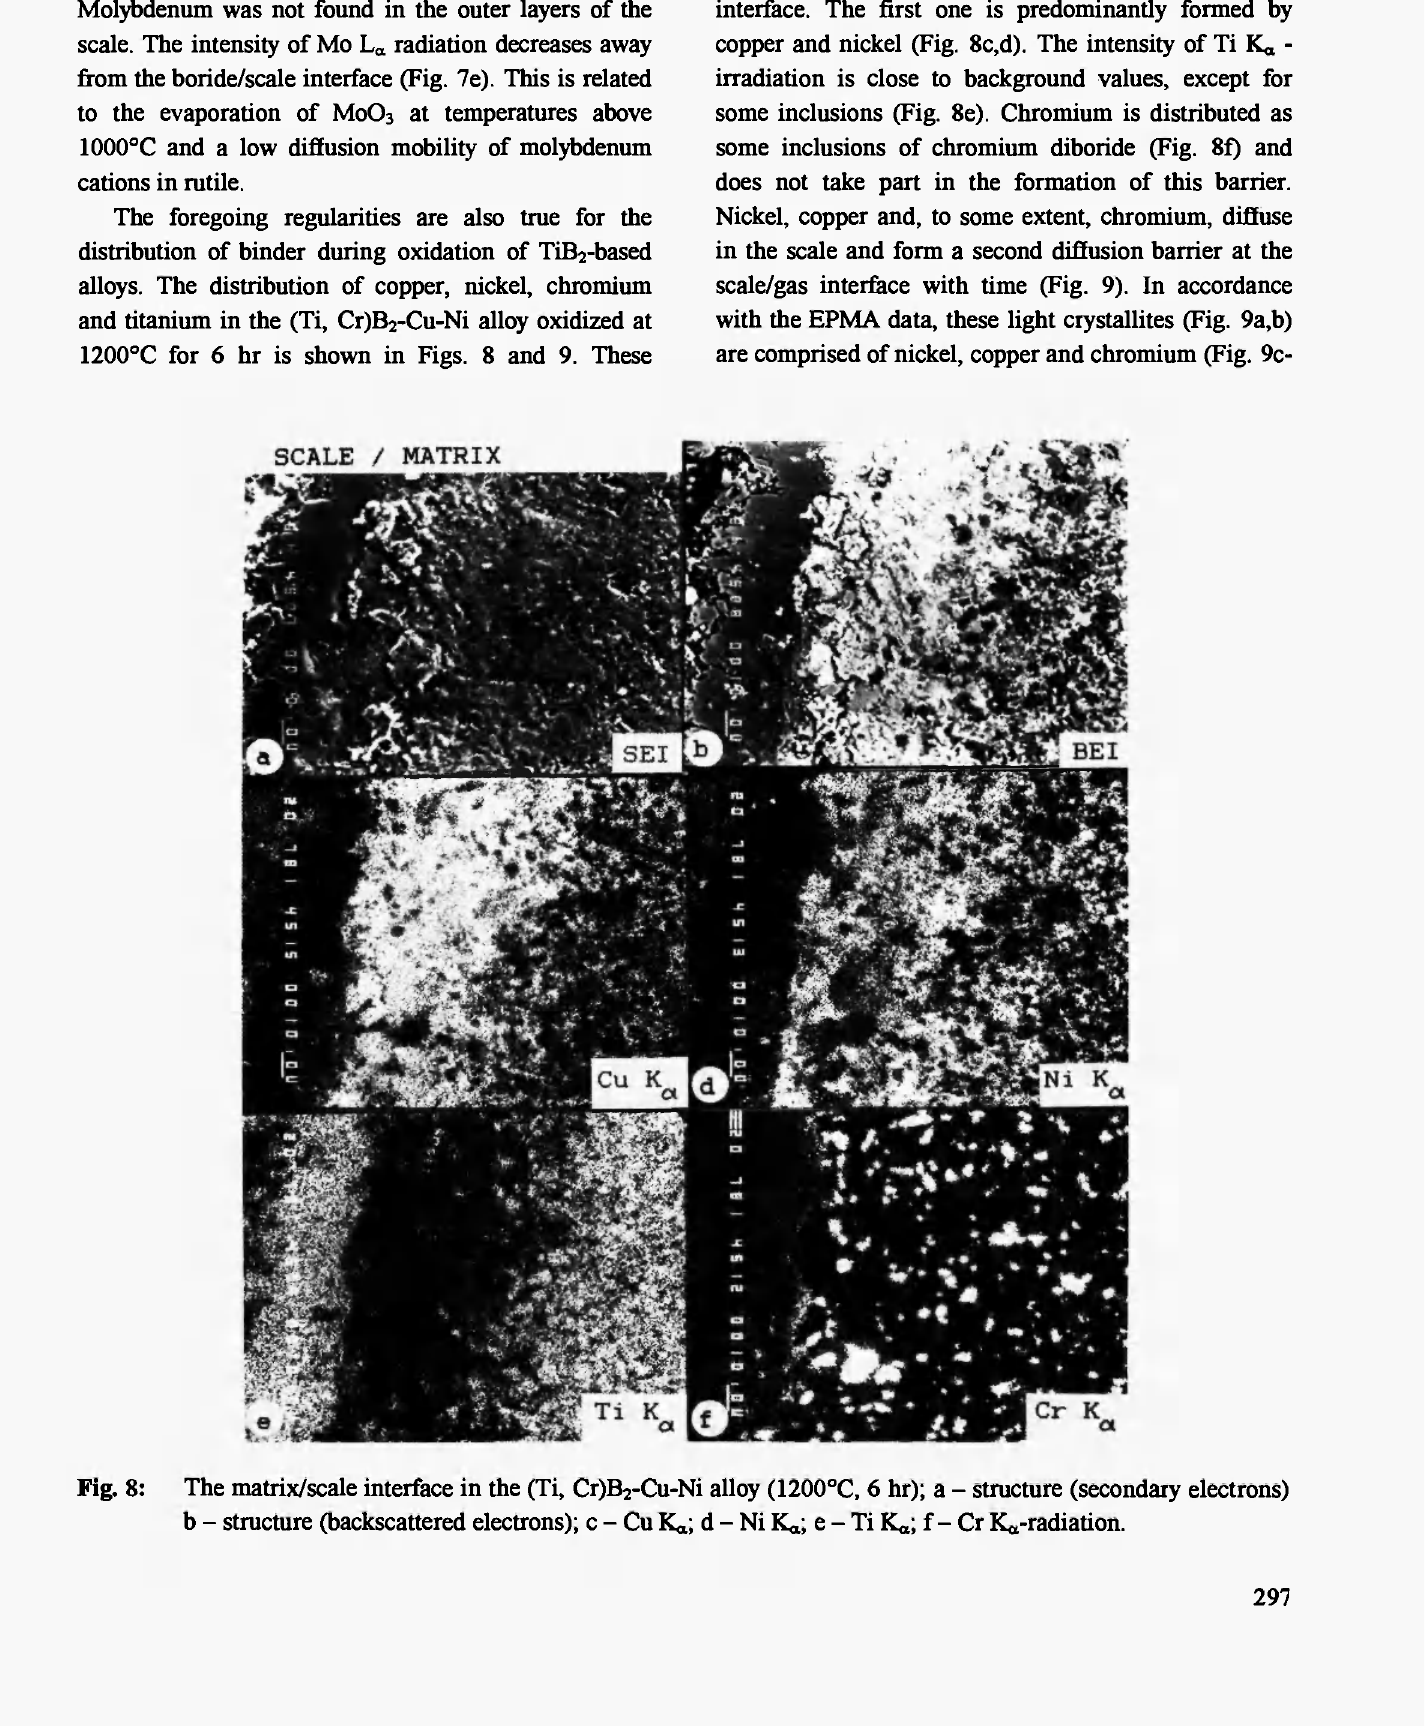
Fig. 8: The matrix/scale interface in the (Ti, Cr)B -Cu-Ni alloy (1200°C, 6 hr); a - structure (secondary electrons) 2 b - structure (backscattered electrons); c - Cu K^; d - Ni K^; e - Ti K«; f - Cr Κα-radiation.